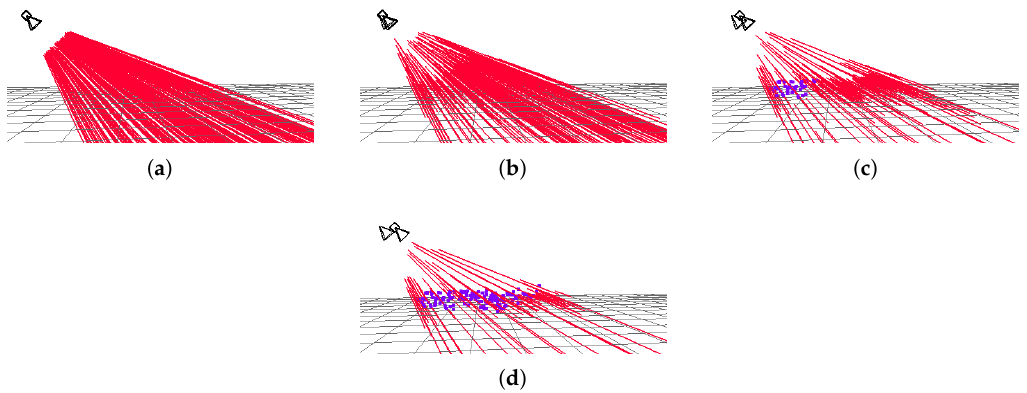
Figure 3. Depth convergence after 1 ( a ) 5 ( b ), 10 ( c ) and 15 ( d ) iterations. Red lines represent depth uncertainty in non-converged 3D points, blue points represent converged (and fixed) 3D